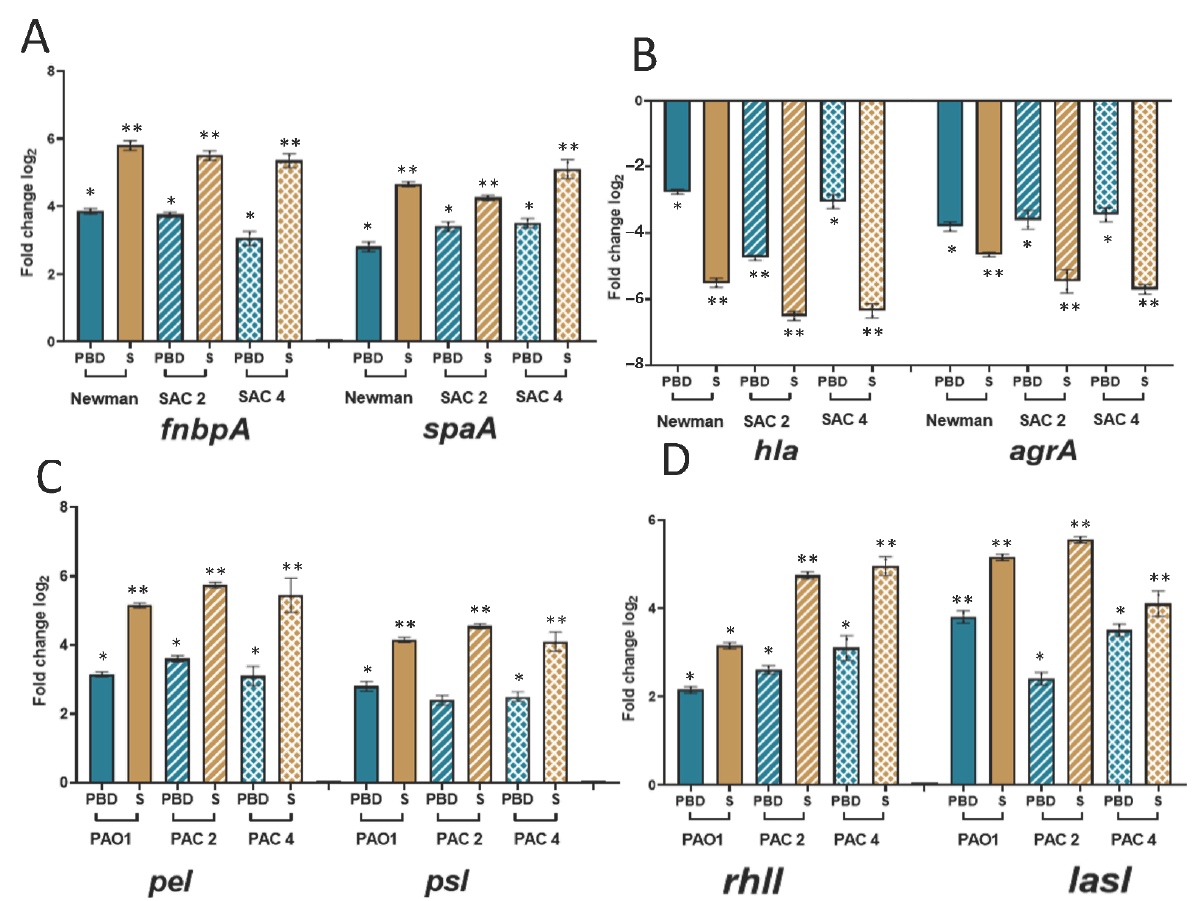
Figure 5. Log relative fold-change in mRNA expression by qRT-PCR of genes involved in biofilm formation for planktonic initial, planktonic biofilm-detached (PBD, blue)) and sessile (S, yellow) S. aureus and P. aeruginosa strains cultivated 72-h alone in CWM inside the open microfluidic system BioFlux TM 200. Log relative fold change in expression was determined for fnbpA , spaA ( A ), hla , agrA ( B ) in S. aureus and pel , psl ( C ), rhII , lasI , ( D ) in P. aeruginosa . Reference strains are represented by solid colors, the two clinical strains are represented in squared and hatched patterns. Samples were tested in triplicate in two independent experiments. Results are expressed as the mean fold change (planktonic initial cells representing the control standardized and the reference) with error bars rep- resenting the standard deviation. Statistics were performed using one-way ANOVA followed by Dunnett’s multiple comparisons test on GraphPad Prism version 9.2. * p < 0.1; ** p < 0.01.